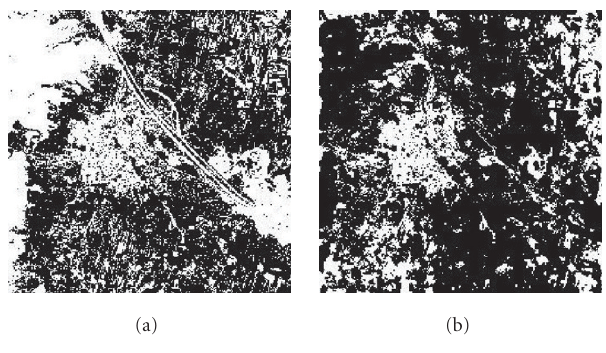
Figure 8: Urban area against the other binary classifications.